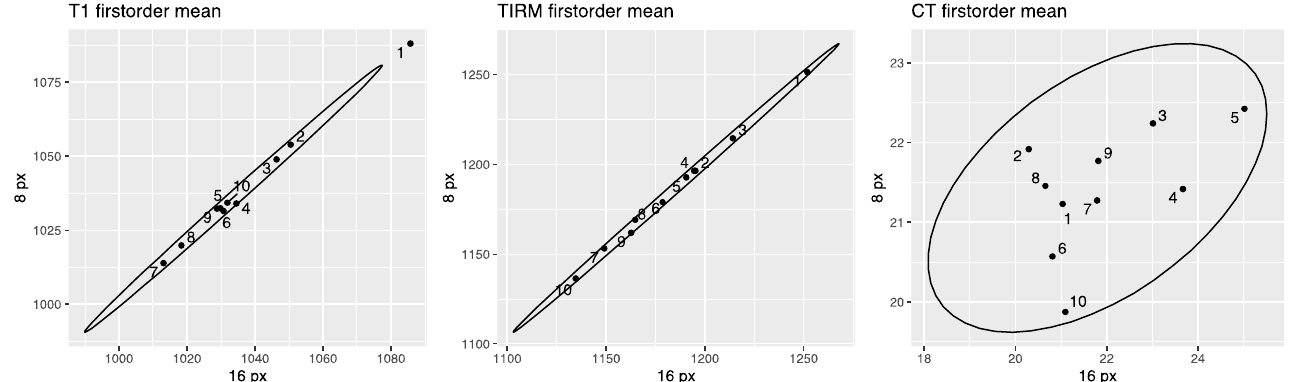
Figure 5. Correlation plots for the first-order feature mean for ROI sizes 8 and 16 pixels in CT and MR images. T1w MR-derived mean on the left, T2w TIRM MR-derived mean in the middle, and CT-derived mean on the right. Data points are defined by the values for the 8-pixel ROI (ordinate) and the 16-pixel ROI (abscissa). The narrower ellipse of the MR data compared to the CT data illustrates that the discrepancy between the ROI sizes is smaller. Correlation plots of all features are provided in the Supplementary Materials (see Figures S4).